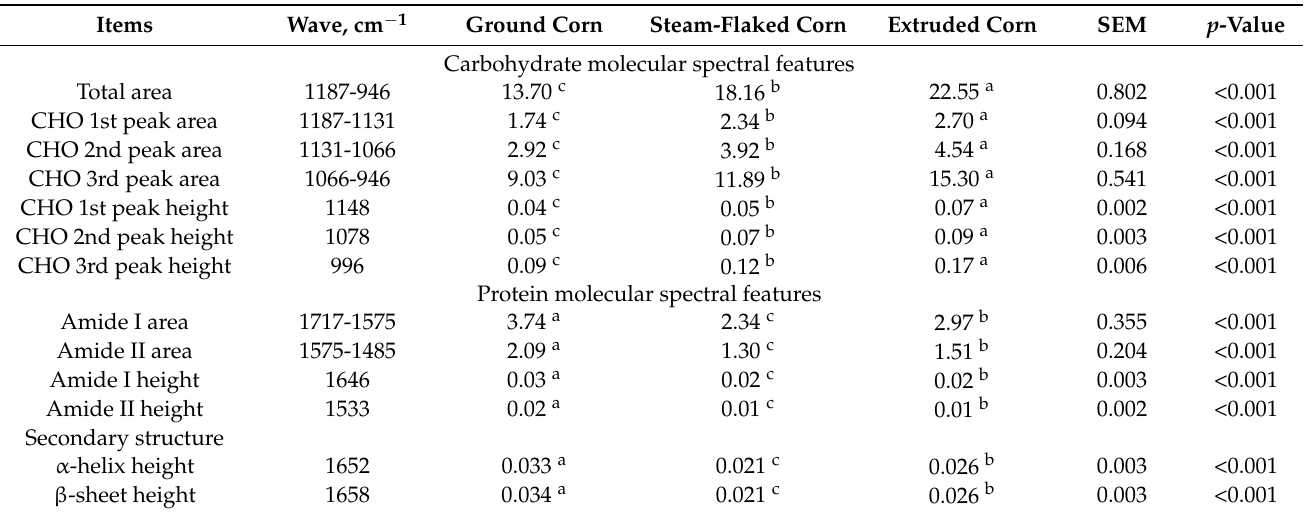
Table 3. Molecular spectral features of carbohydrates and proteins of corn processed in different ways